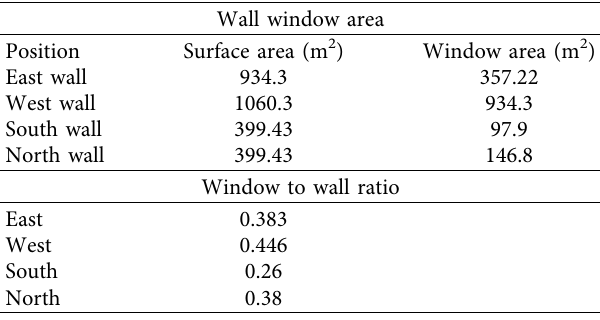
Figure 1: Basic parameters of building envelope. Table 3: Area and ratio of window wall.